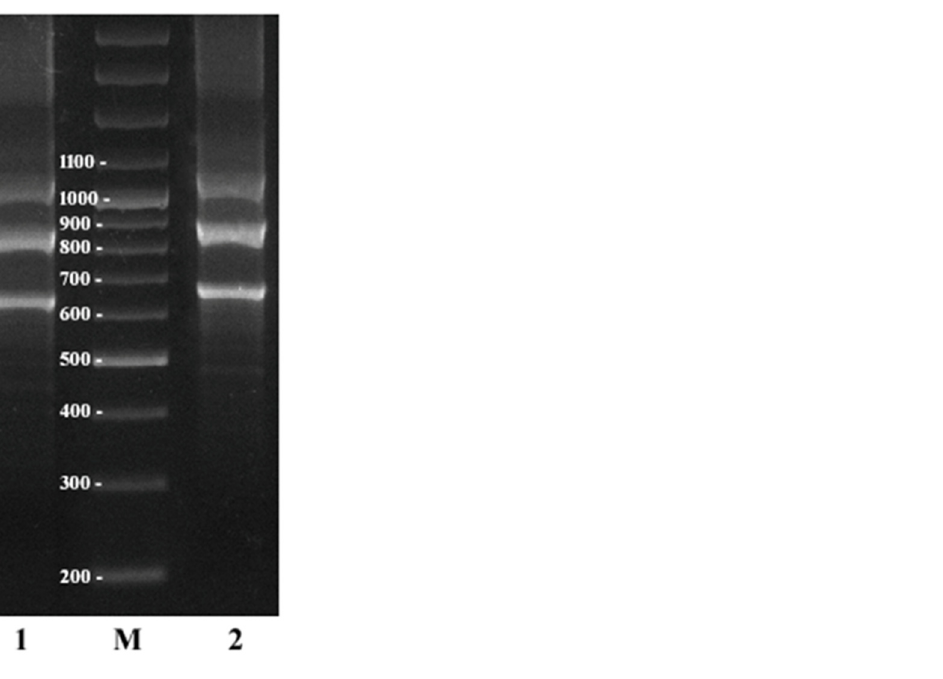
Figure 8. The results of PCR with CS-237r1/igs2004r ( 1 ) and CS-237r2/igs2004r ( 2 ) primer pairs in C. sativa . M—molecular weight marker with 100 bp steps.